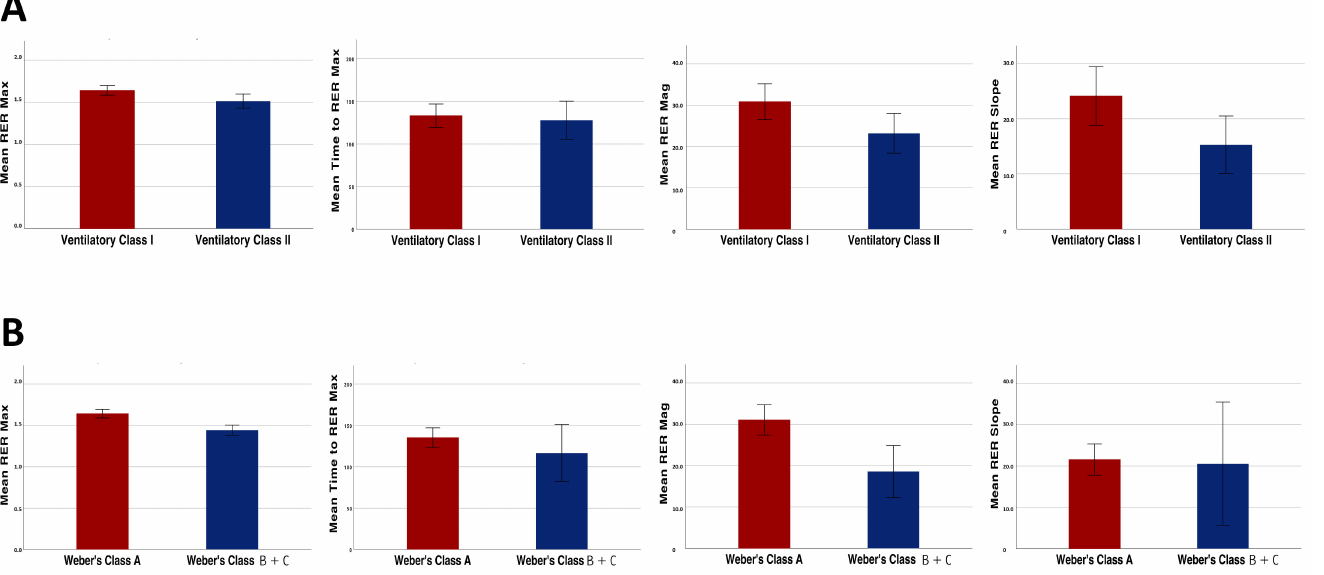
Figure 3. Differences in the recovery parameters (RER max, RER mag, RER recovery slope and time to reach RER max) between the patients belonging to different ventilatory efficiency classes ( A ) and Weber’s fitness classes ( B ). Similar results were found when dividing the patients based on their aerobic